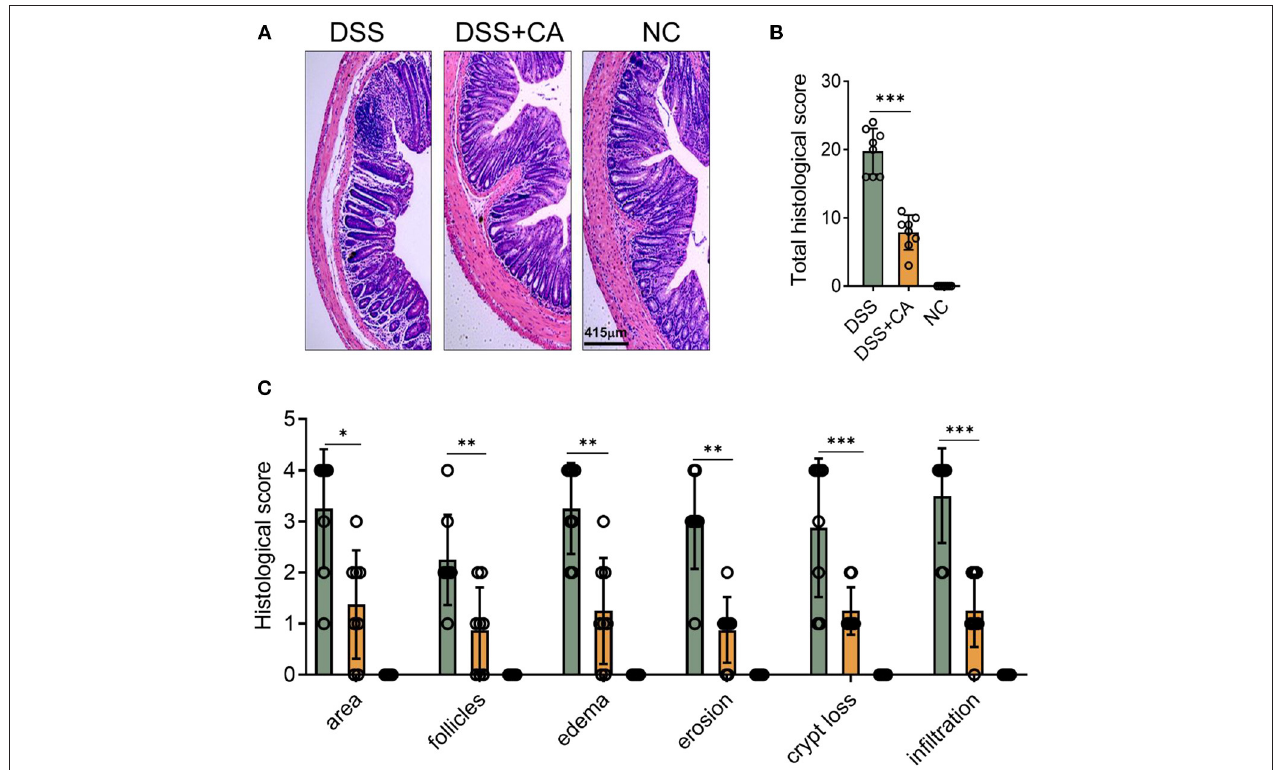
FIGURE 2 | CA alleviates pathological alterations in DSS-induced colitis. Colitis was induced as described in Figure 1 and colon samples were collected on day 10. (A) Histological analysis of colonic sections. Representative images of H-E-stained colonic sections of each group. (B) Total histological scores were the sum of all sub-scores shown in (C) . (C) Colonic sections were scored on a scale of 0–4 based on the percentage of colon involvement by inflammation, percentage of crypt loss, presence of lymphoid follicles, edema, erosions, and density of infiltrating inflammatory cells. Data are presented as mean ± SD. Representative data of three independent experiments are shown. One-way analysis of variance (ANOVA) followed by Tukey’s multiple comparisons test, * p < 0.05, ** p < 0.01, and *** p <